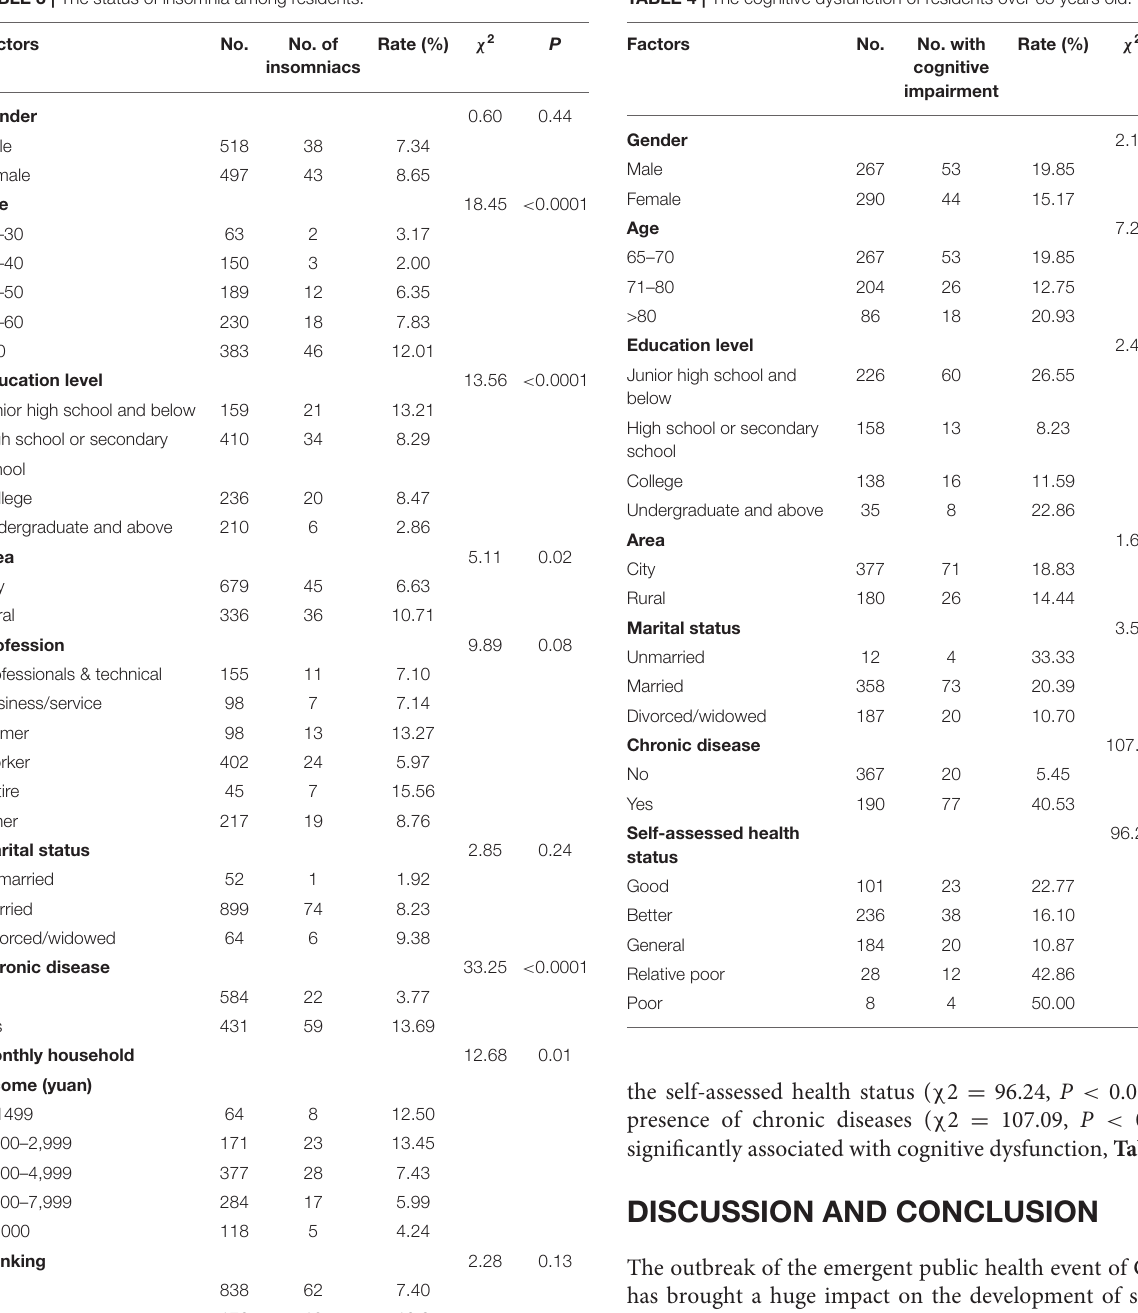
TABLE 3 | The status of insomnia among